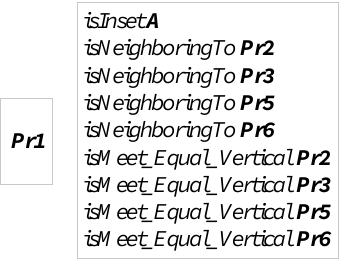
Figure 10. The relations and properties of the instance Pr1.